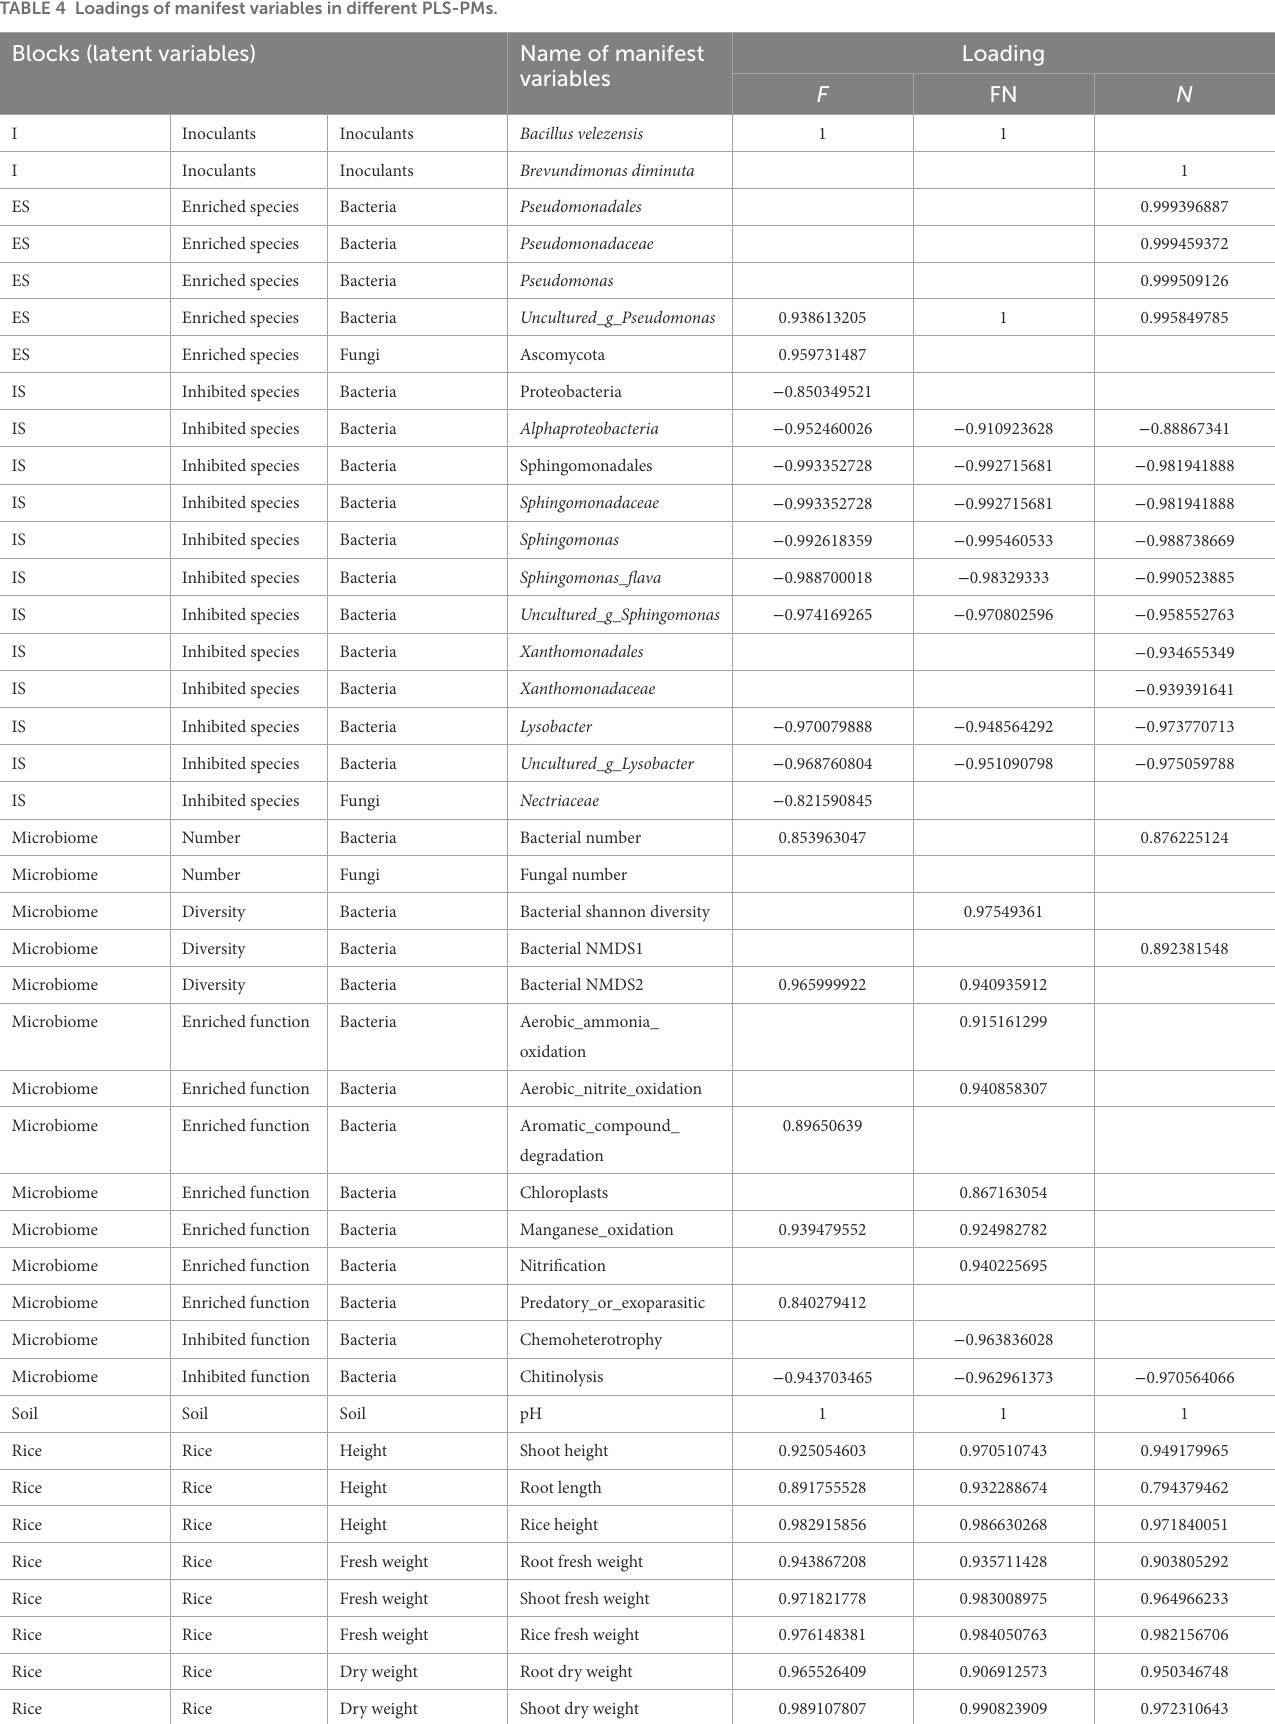
TABLE 4 Loadings of manifest variables in different PLS-PMs. Blocks (latent